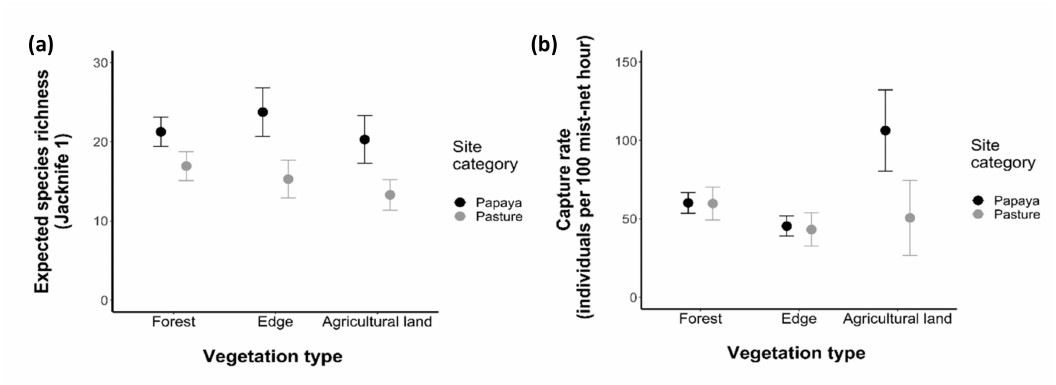
Figure 5. Comparison between site categories and vegetation types. ( a ) Mean expected species richness obtained with Jackknife 1; ( b ) mean capture rates at di ff erent vegetation types within sites categories. Dots represent the mean values for the expected richness, taking the average of the replicates per vegetation type within each site category. Lines represent standard error bars (mean ± standard error